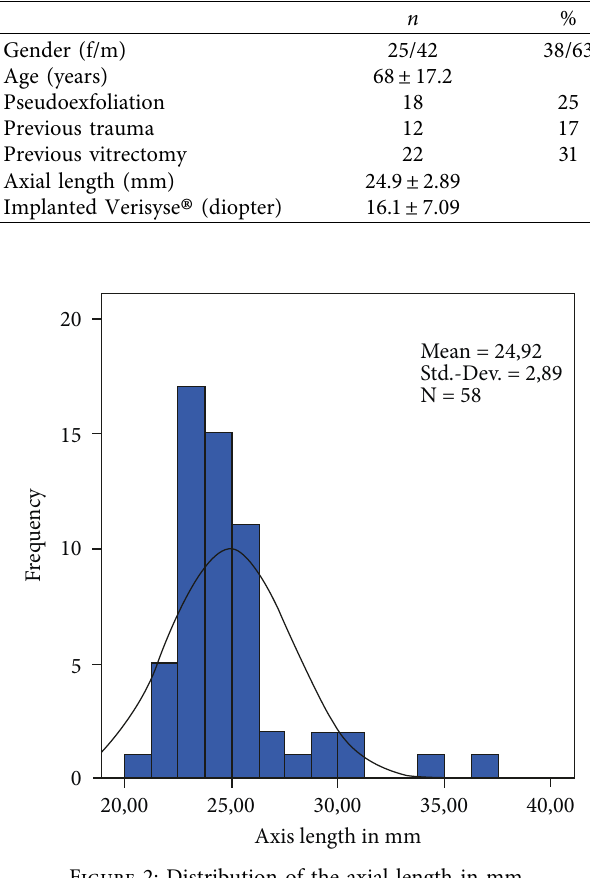
Figure 2: Distribution of the axial length in mm.